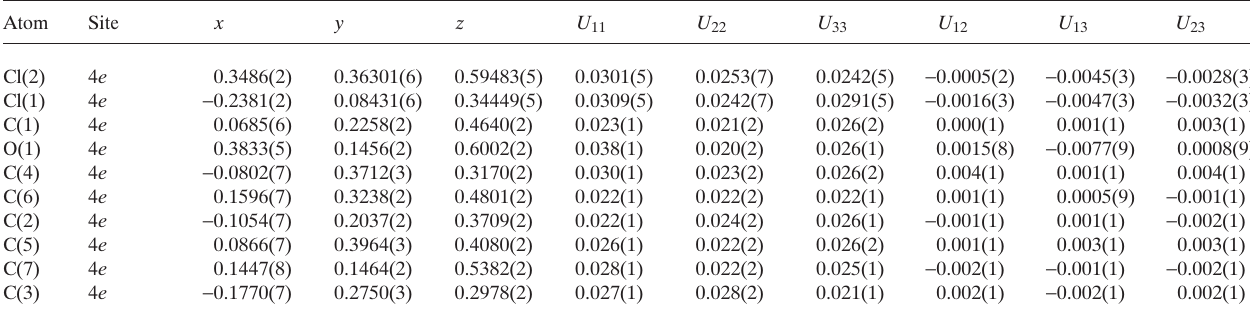
Table 3. Atomic coordinates and displacement parameters (in Å 2 )